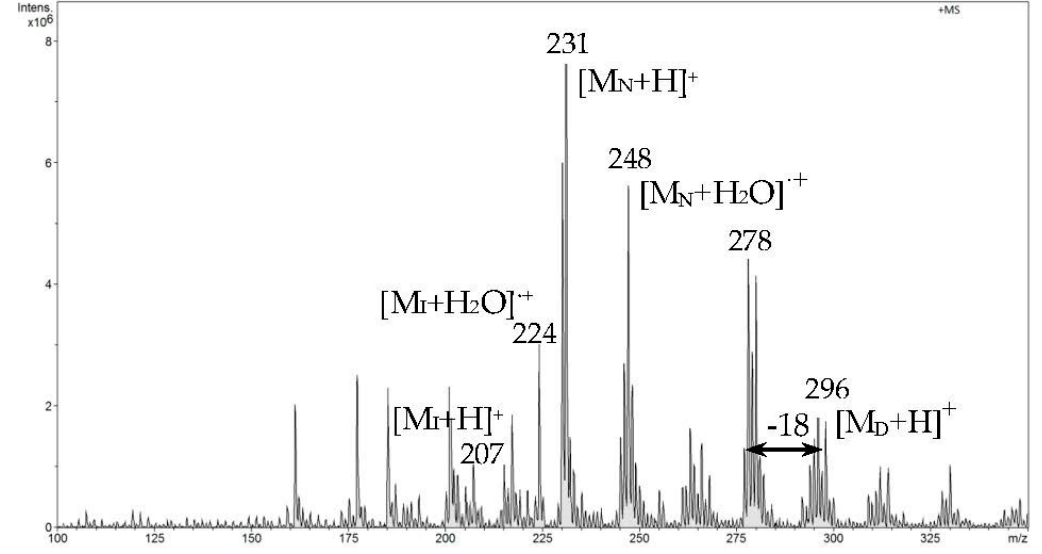
Figure 11. FAPA-MS spectrum of all analytical signals recorded at 160 ◦ Figure 11. FAPA ‐ MS spectrum of all analytical signals recorded at 160 °C. Figure 11. FAPA ‐ MS spectrum of all analytical signals recorded at 160 °C.